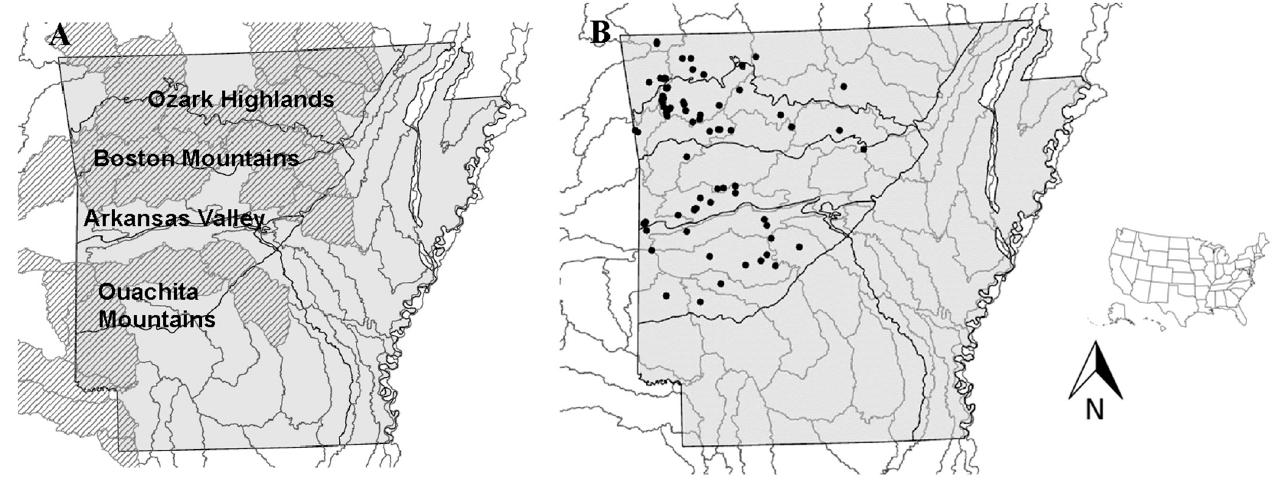
Figure 1. ( A ) Historic distribution of A. mohri across Omernik Level III ecoregions. The HUC8 units that overlapped with A. mohri presence watersheds from Poulton and Stewart, 1991 are hatched. The HUC8 units in Arkansas that did not have A. mohri presence are outlined. ( B ) Locations of the 74 reaches sampled in the present study. The northernmost site coordinates are (36.44117572, − 94.22998045) southernmost site coordinates are (34.68526175, − 94.32049797). Sample reaches fell within the following HUC8 units: Ouachita Headwaters, Upper Saline, Fourche La Fave, Poteau, Petit Jean, Frog-Mulberry, Dardanelle Reservoir, Robert S. Kerr Reservoir, Beaver Reservoir, Bull Shoals Lake, Elk, Little Red, Middle White, Buffalo, Upper Ouachita, Little Missouri, Lower Little, Illinois.